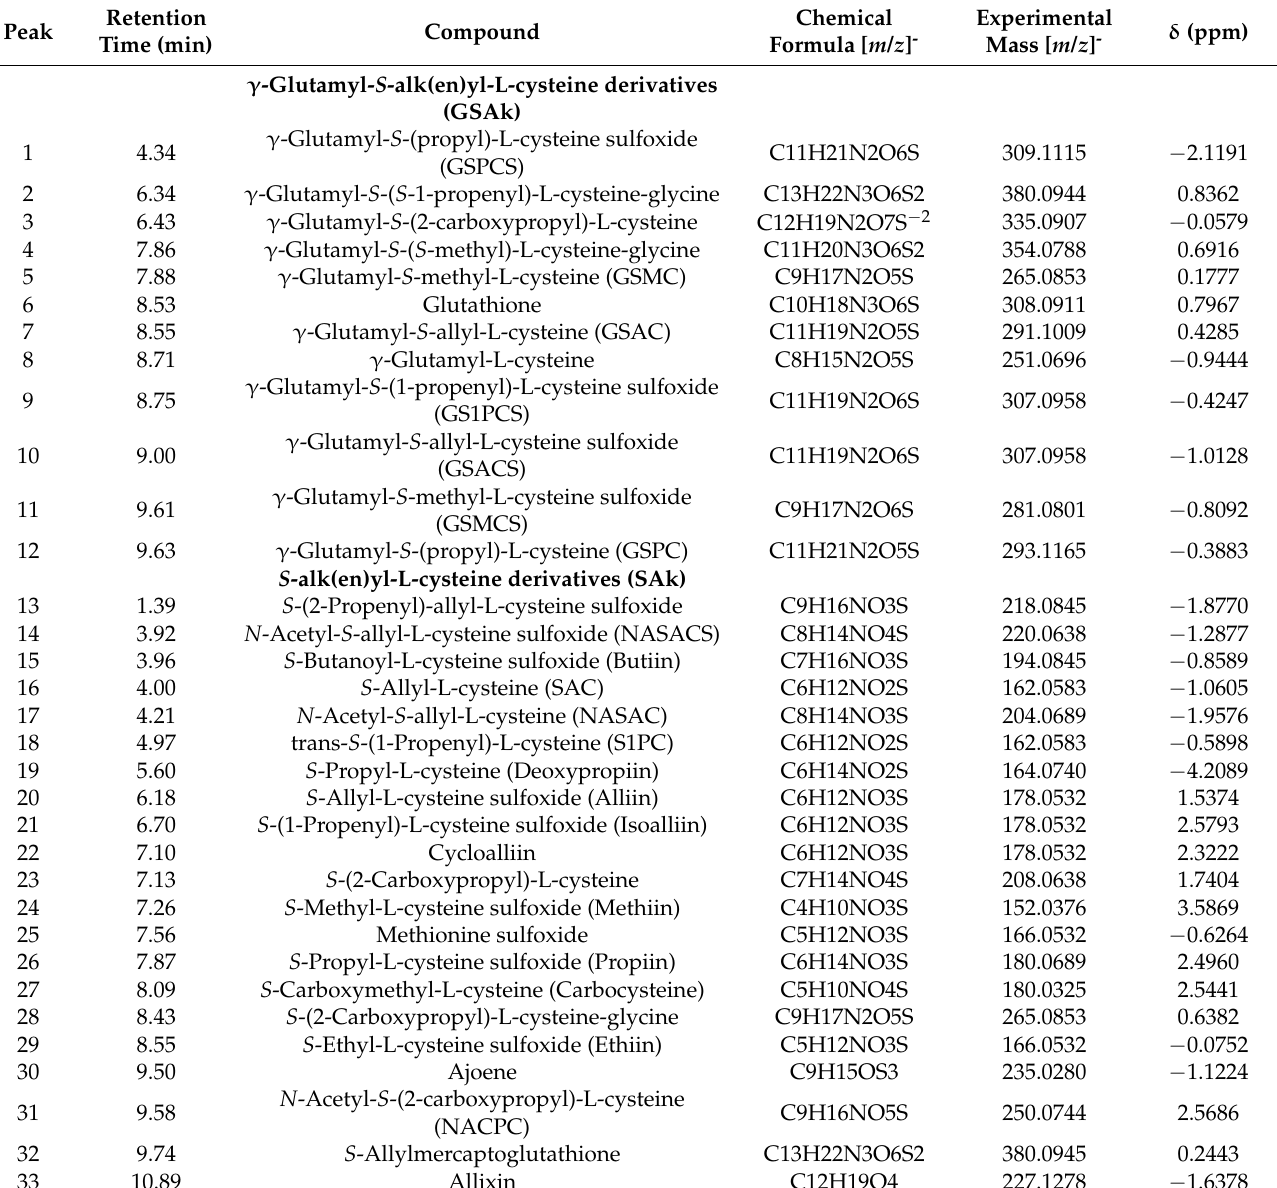
Table 2. UHPLC-HRMS-based identification of organosulfur compounds detected in human urine samples after acute intake of 20 g of black